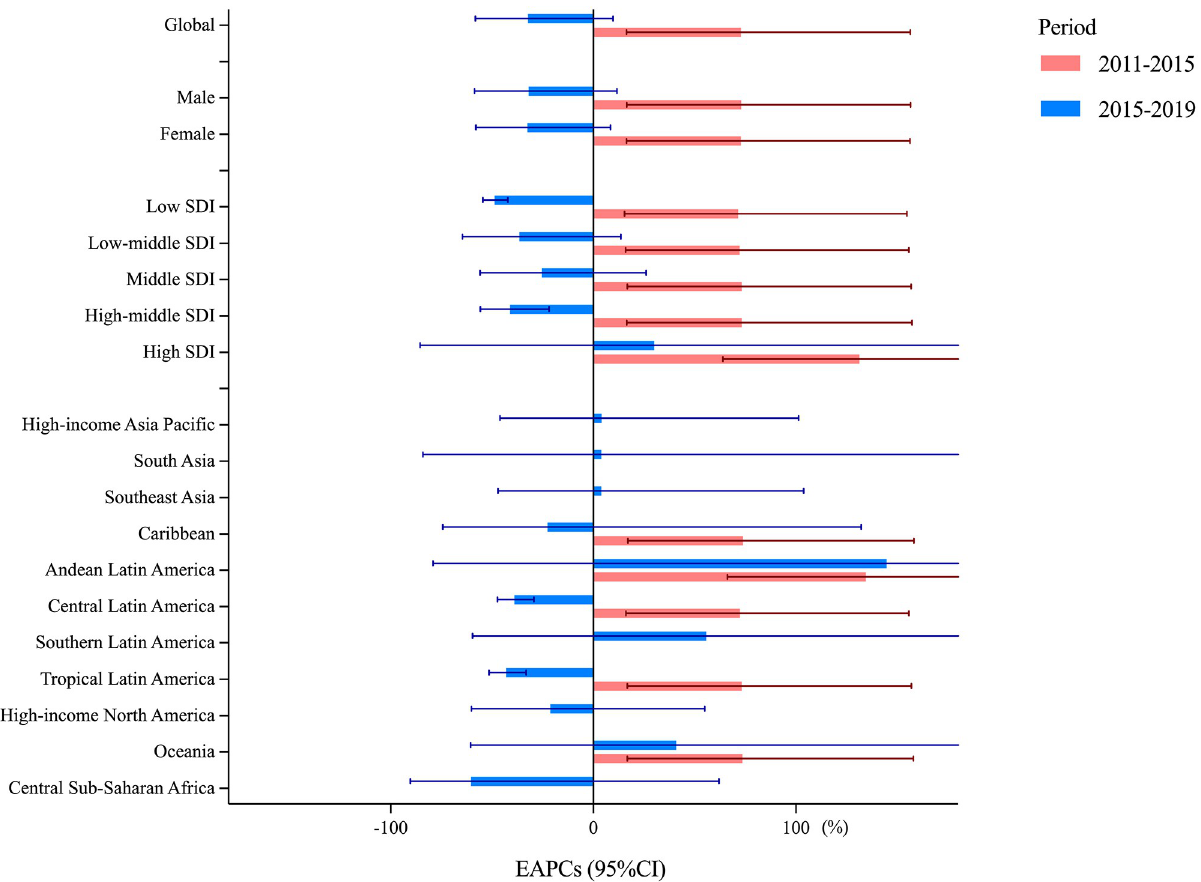
Fig 2. The EAPCs of ZIKV infection ASRs from 2011 to 2015, and from 2015 to 2019 by regions. EAPC, estimated annual percentage change; ASR, age-standardized incidence rate; CI, confidence interval; SDI, Socio-demographic Index.